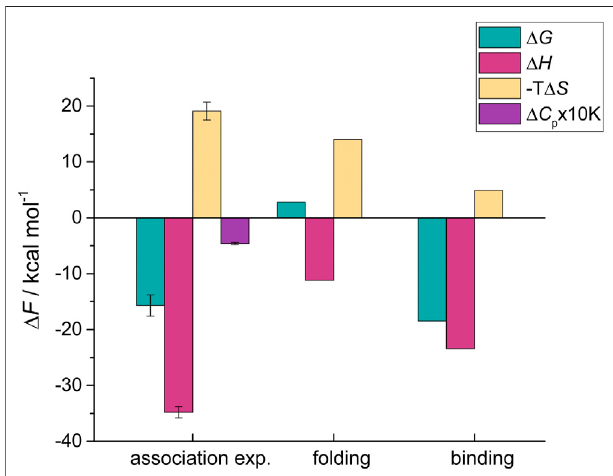
FIGURE 2 | Decomposition of the thermodynamic contributions accompanying HigA2 3 − 23 -HigB2 association into the folding and binding contributions. The overall thermodynamic parameters for association were determinedusingthecompetitionITCexperimentsandareshownin fi rst set of bars on the left (association exp.). The folding contributions (middle) were estimated from the LR model and were subtracted from the overall valuesto obtain thebinding contributions, shown onthe right. Parameters are reported at T (cid:1) 25 °